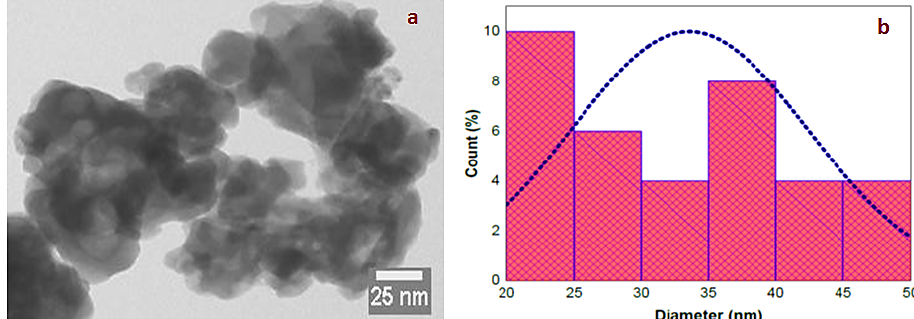
Figure 7. ( a ) TEM image of mancozeb nanoformulation and ( b ) size distribution curve.